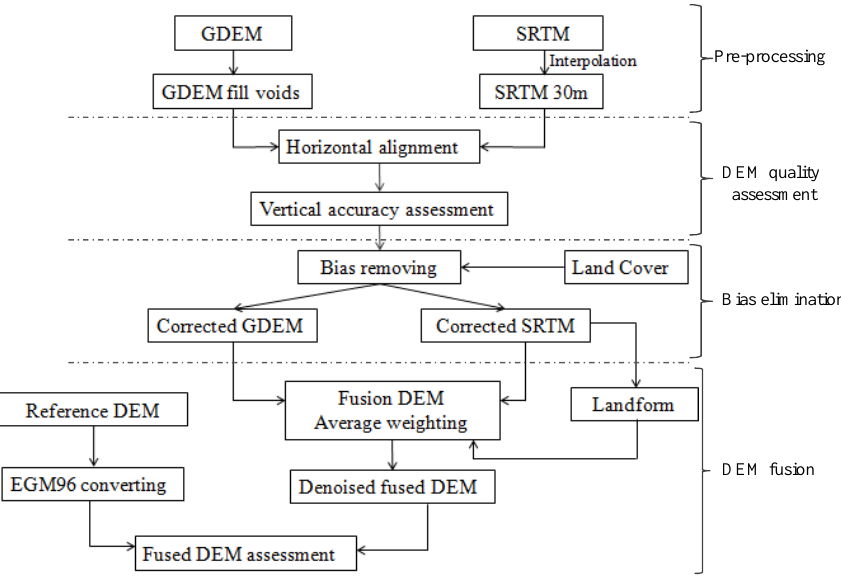
Figure 2. Flowchart of data